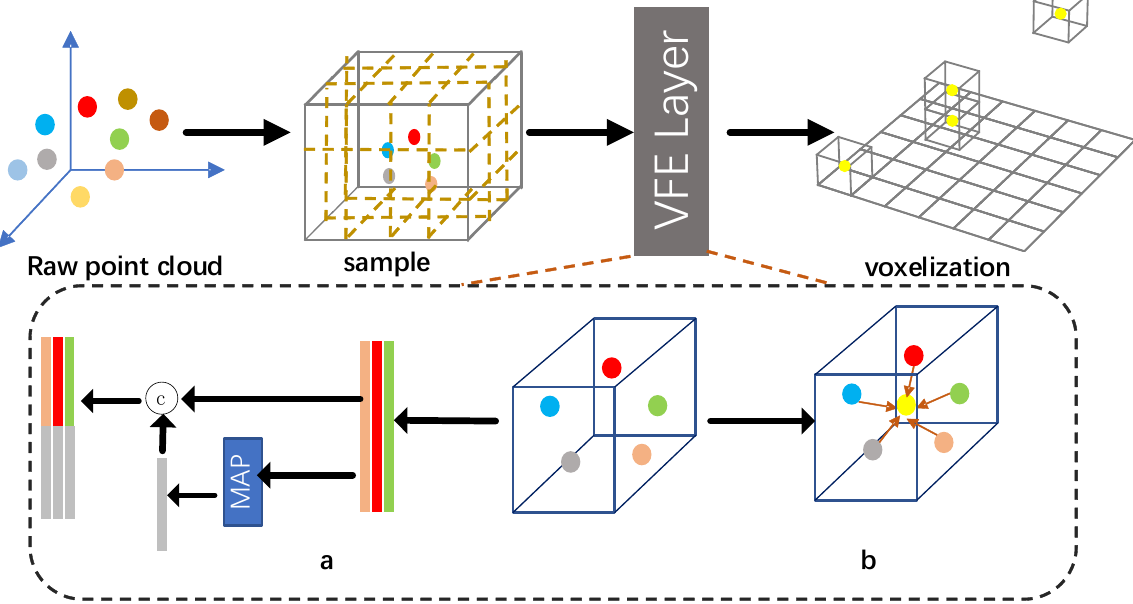
Figure 3. Voxel feature encoding layer. ( a ) Complex encoding method by stacking layers. ( b ) Computing mean value of inner points in voxel grid.